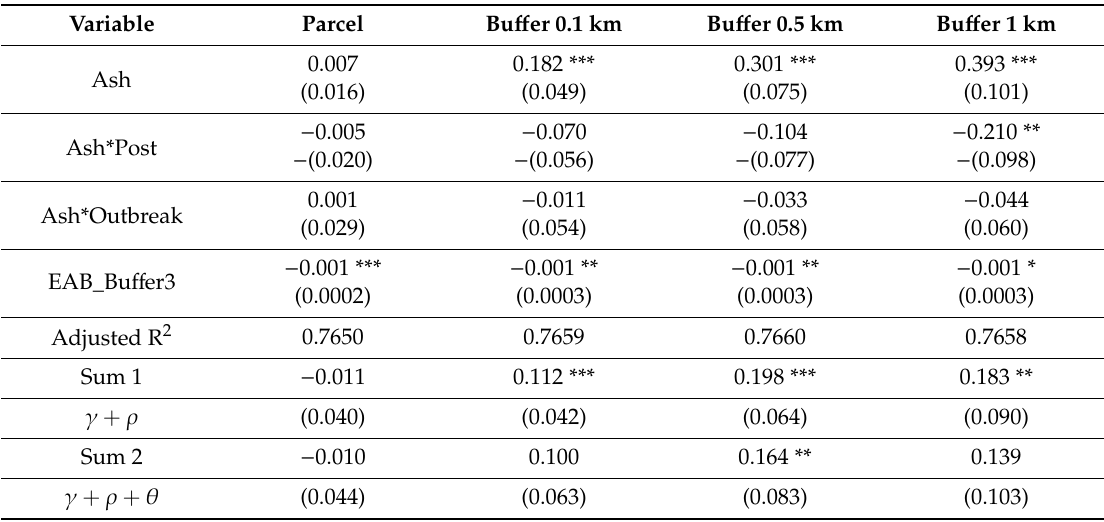
Table 6. Coe ffi cient Estimates of Hedonic Model 4, Ash and emerald ash borer (EAB), 2008–2015 ( n =